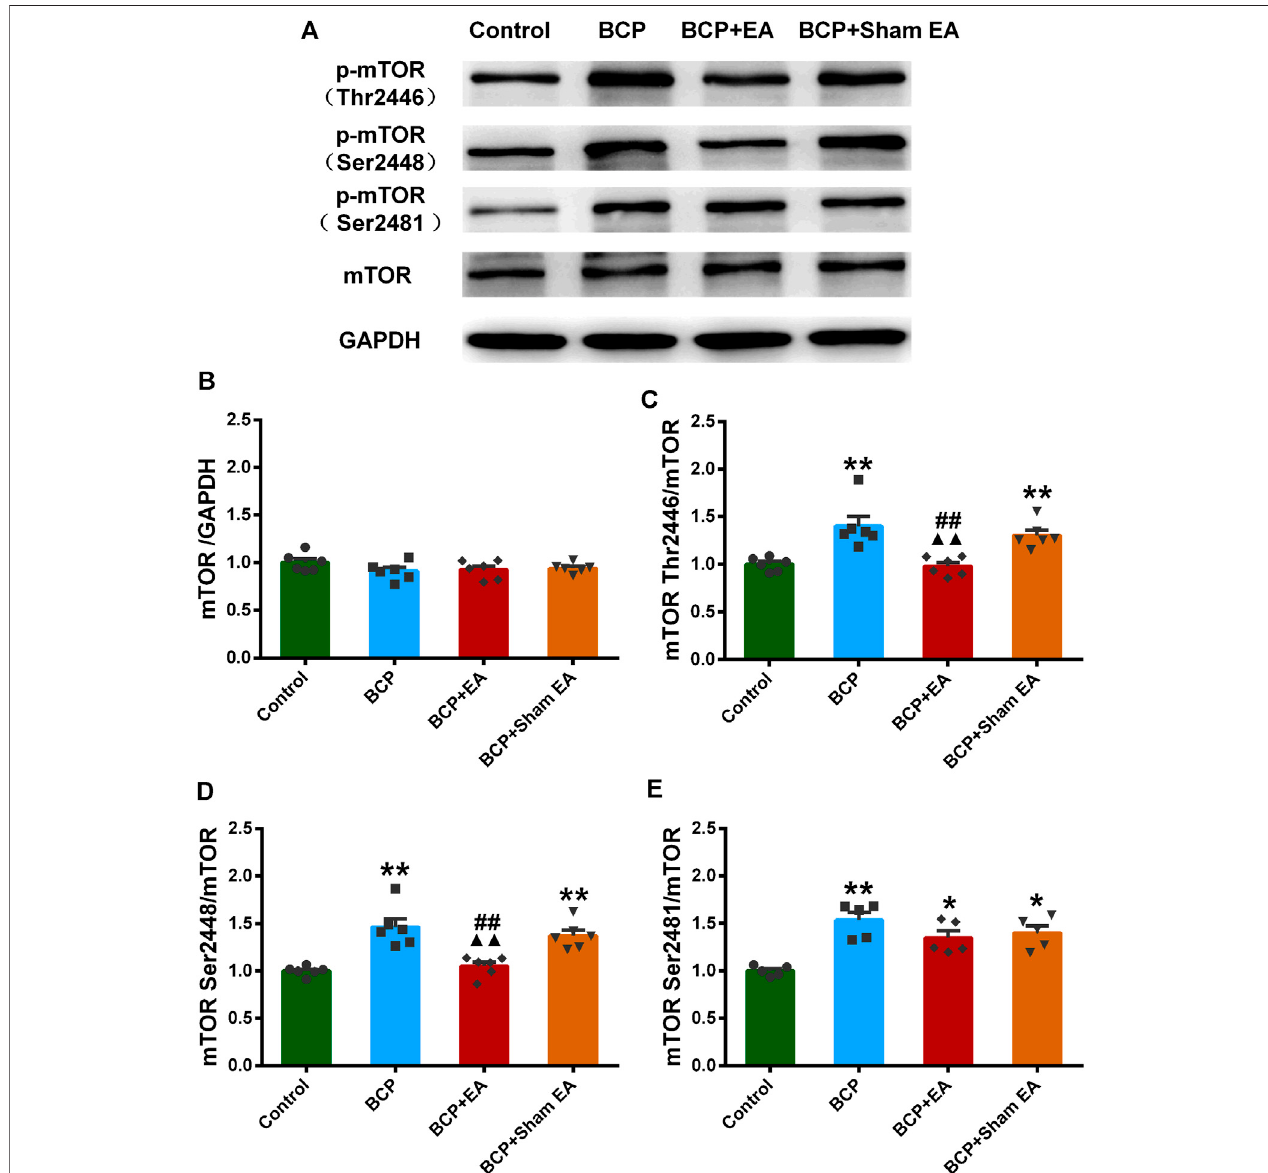
FIGURE 6 | Regulation effects of EA on the phosphorylation of mTOR (Thr2446, Ser2448, and Ser2481). (A) The representative WB band; (B) the expression of mTOR total protein, N (cid:2) 6 rats/group; (C) the expression of p-mTOR Thr2446, N (cid:2) 6 rats/group; (D) the expression of p-mTOR Ser2448, N (cid:2) 6 rats/group; (E) the expression of p-mTOR Ser2481, N (cid:2) 5 rats/group. * p < 0.05, ** p < 0.01, compared with the control group; ▲▲ p < 0.01, compared with the BCP group; ## p < 0.01, compared with the BCP + sham EA group.